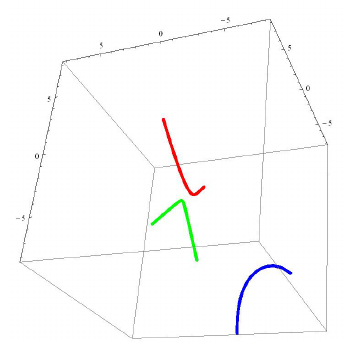
Figure 7. The positions of r (red), ˜ r (blue) and ¯ r (green).